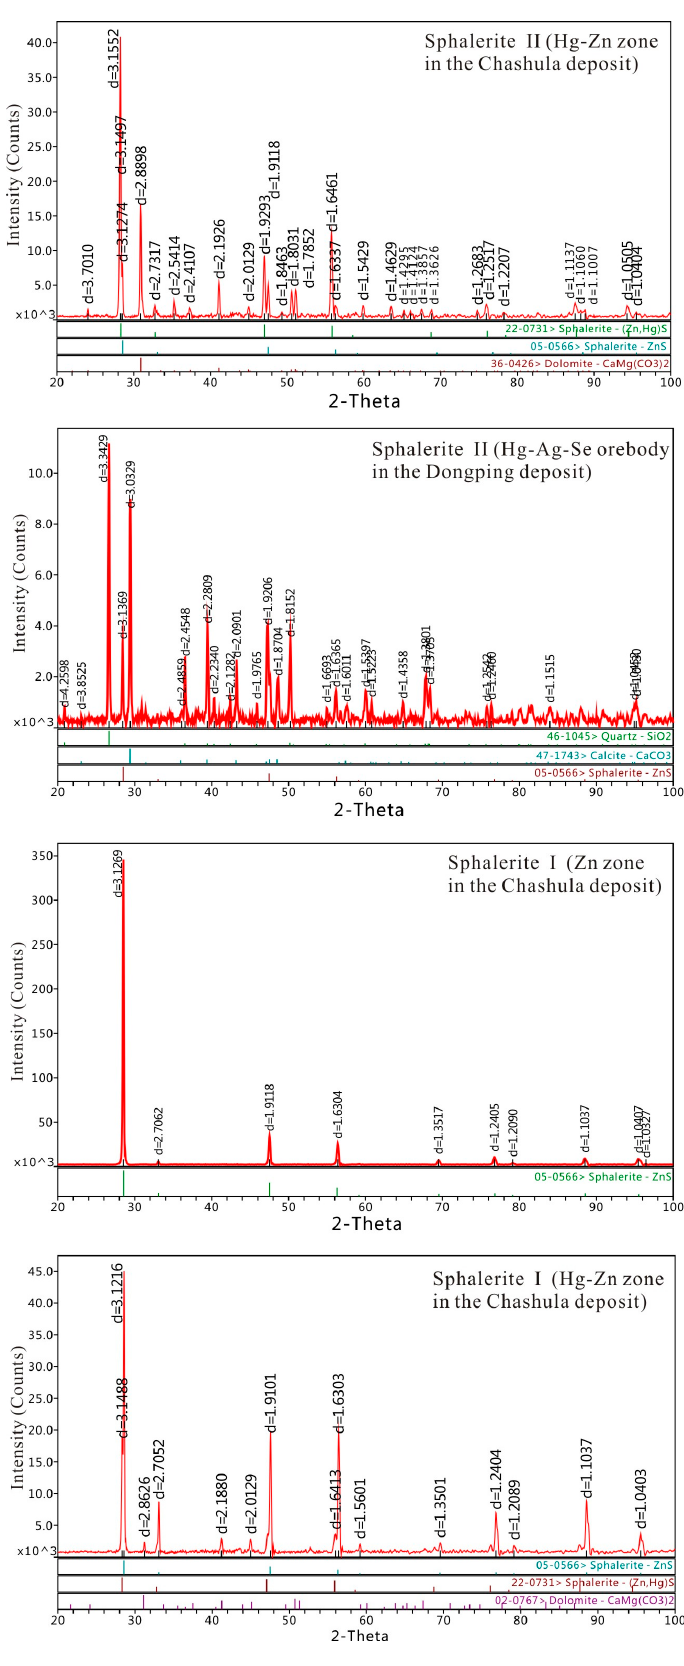
Figure 11. X-ray diffraction patterns of sphalerite II and I (peak data listed in Table 4) with ICDD references.